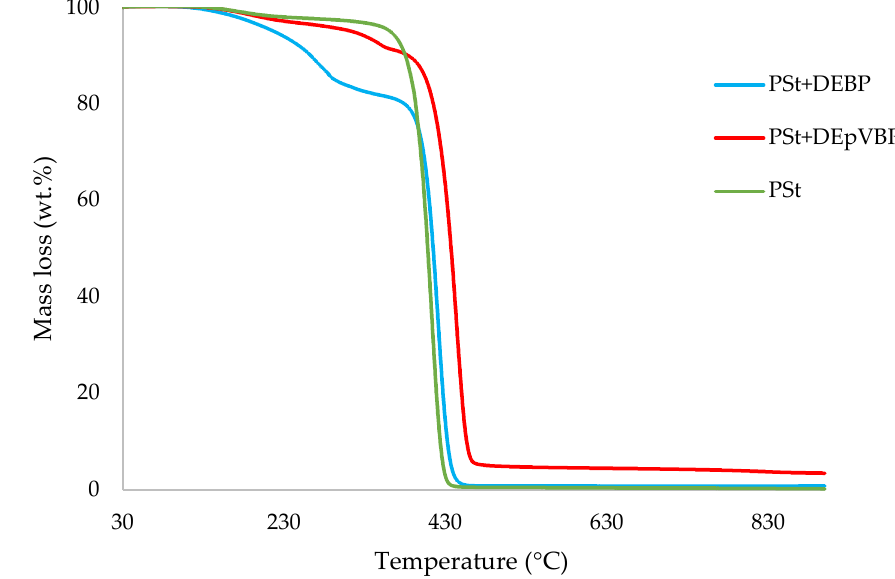
Figure 5. An overlay of the TGA curves of PSt and PSt+aromatic phosphonate materials, at 10 °C min −1 in nitrogen, from 30 to 900 °C.